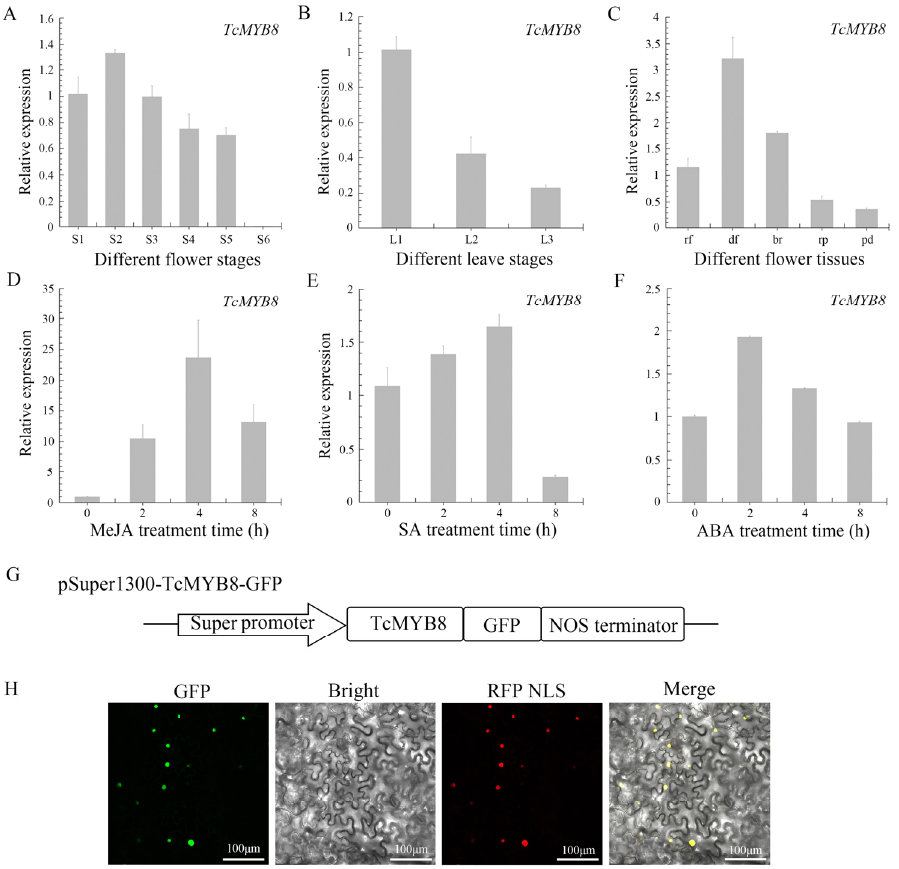
Figure 2. Expression analysis of the TcMYB8 gene and subcellular localization of the encoded protein. ( A , B ) Analysis of TcMYB8 expression by qRT-PCR in flowers ( A ) and leaves ( B ) at different developmental stages. S1–S6 and L1–L3 represent the different developmental stages of flowers and leaves, respectively. S1: bud stage; S2: half of the peripheral ray florets open; S3: 1st row of disk florets open; S4: half of the rows of disk florets open; S5: all rows of disk florets open; S6: past flowering; L1: small leaves (5–10 mm in width); L2: medium leaves (15–20 mm in width); L3: large leaves (>25 mm in width). ( C ) qRT-PCR analysis of TcMYB8 expression in different tissues of S2-stage flowers; rf, ray florets; df, disk florets; br, bracts; rp, receptacle; pd, pedicel. ( D – F ) qRT PCR analysis of TcMYB8 expression in tissue culture seedlings at 0, 2, 4, and 8 h after treatment with MeJA ( D ), SA ( E ), and ABA ( F ). ( G ) Diagram of the pSuper1300-TcMYB8-GFP construct. ( H ) Subcellular localization of TcMYB8 in N. benthamiana leaves. Bar = 100 μ m.